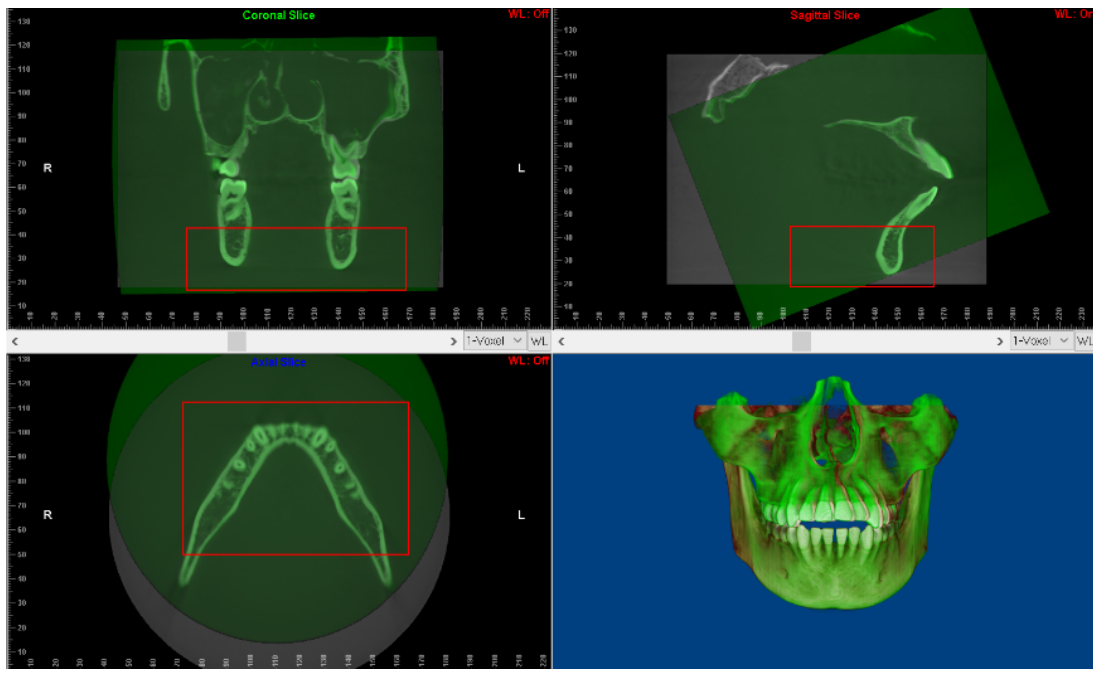
Figure 2. The automatic voxel-based superimposition using the registration reference area of the basal bone of the mandibular body containing no teeth nor alveolar bones.